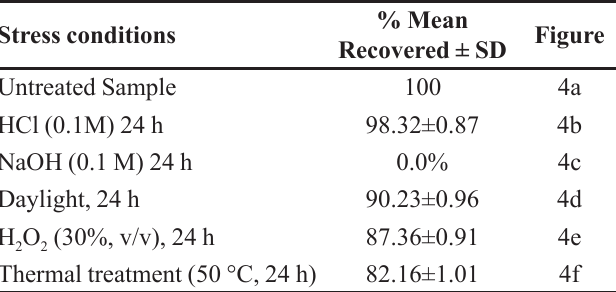
TABLE VI - Stress induced degradation studies Stress conditions